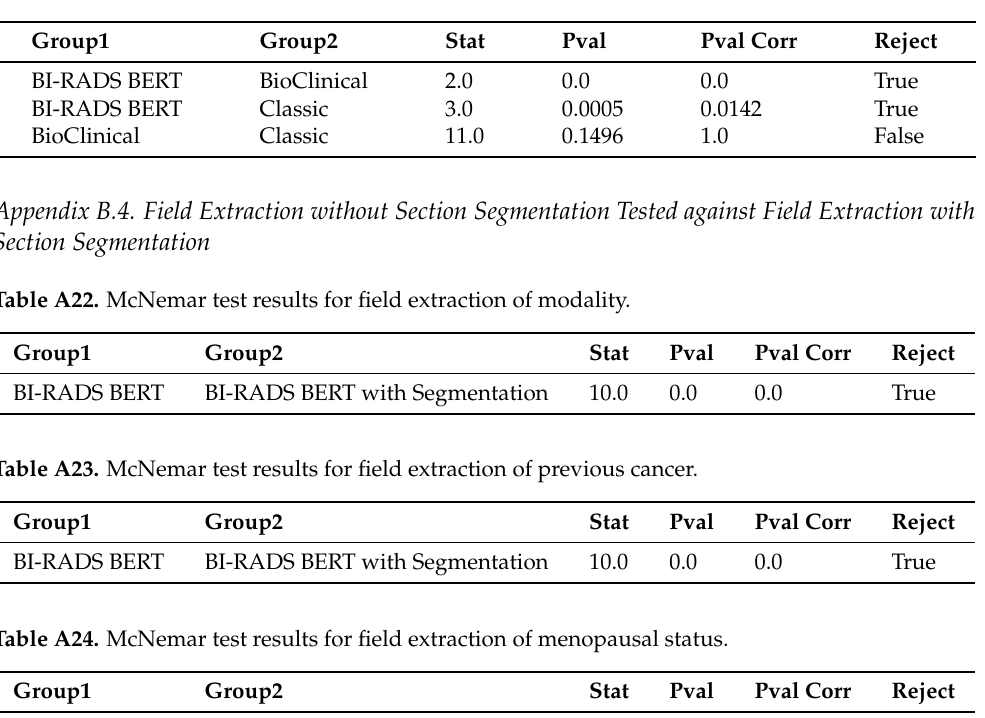
Table A21. Bonferonni-corrected McNemar test results for field extraction with no section segmenta- tion of BPE.